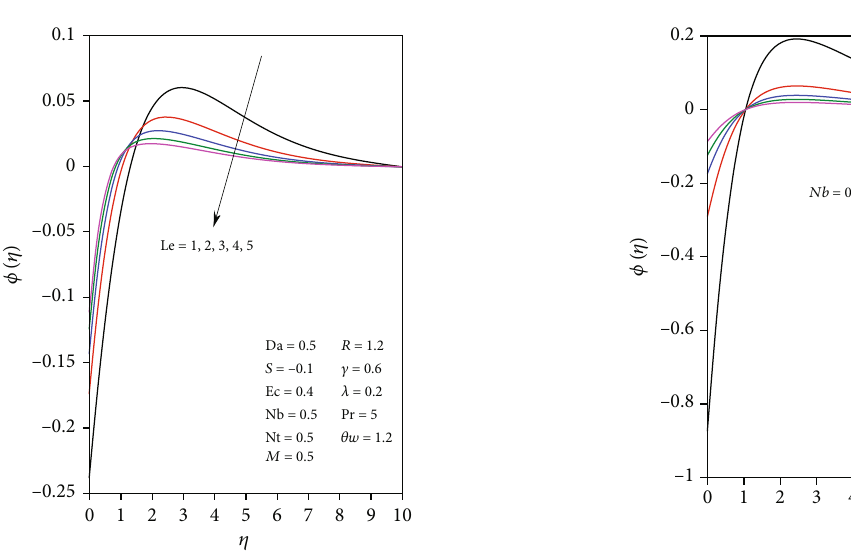
Figure 20: Concentration of nanoparticle pro fi le for di ff erent values of S .